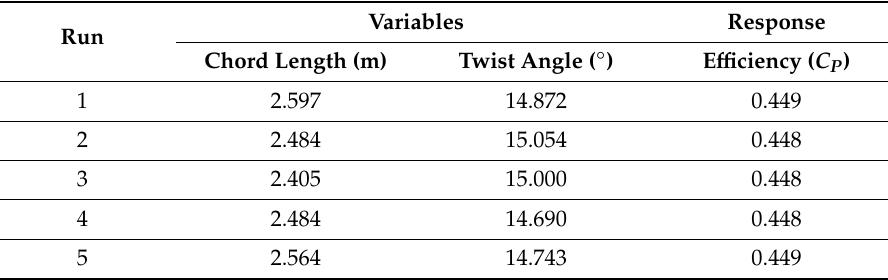
Table 4. Design of the parameters for calculation location